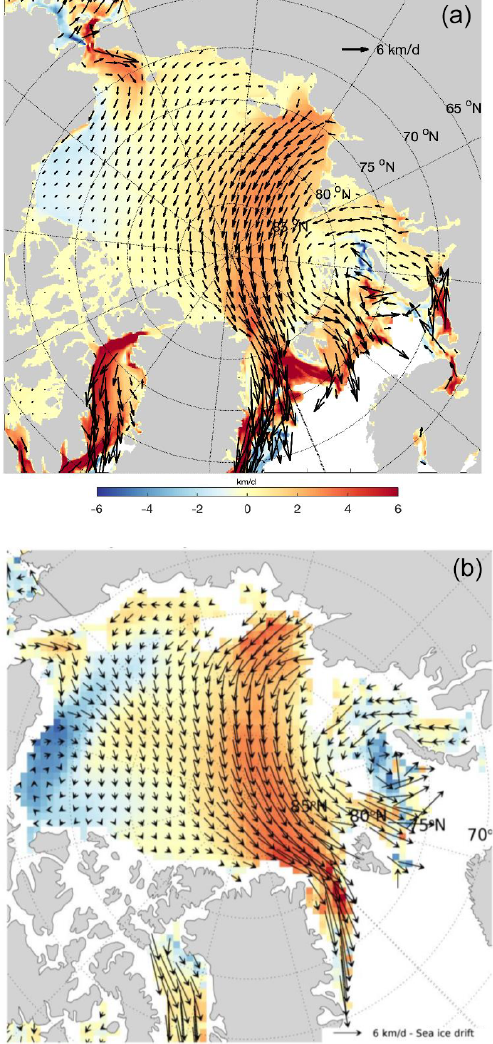
Figure 11. RASM simulations of the sea ice velocity anomaly (a) and the satellite-derived sea ice velocity anomaly (kmd − 1 ) (b) for 2010–2019. The figures were plotted using IDL (Exelis Visual In- formation Solutions,